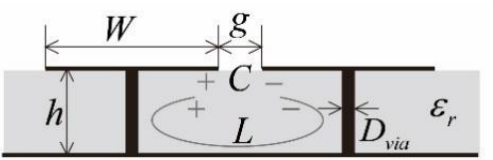
Figure 6. Equivalent LC circuit model of mushroom-like metamaterial.